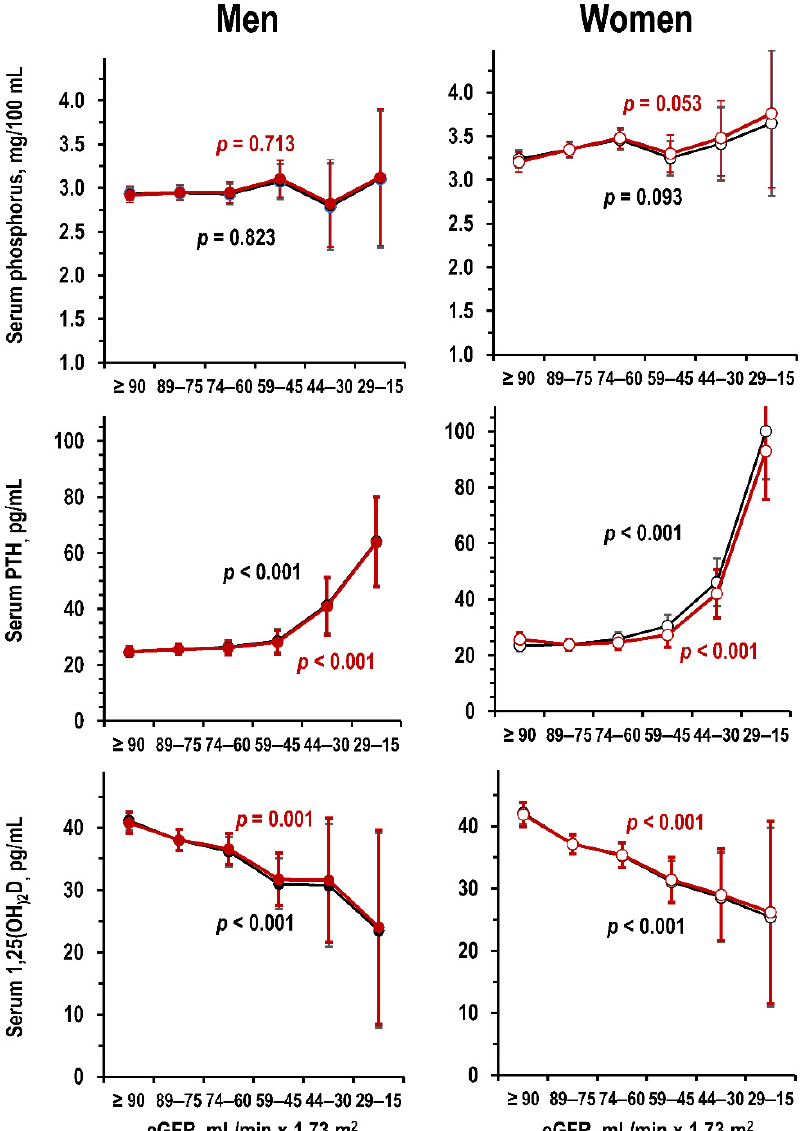
Figure 3. Moli-sani dataset: mean and 95%CI in men and women ( left panels and right panels, respectively) by eGFR stratum of serum phosphorus ( upper panels), serum PTH ( central panels), and serum 1,25(OH) 2 D (lower panels) in uni-variate ANOVA and in ANOVA controlled for age (black line and red line, respectively). Number of individuals per eGFR stratum from left to right: men = 195, 168, 88, 30, 5, and 2—women = 139, 175, 107, 36, 8, and 2. No individual had eGFR < 15 mL / min × 1.73 m 2